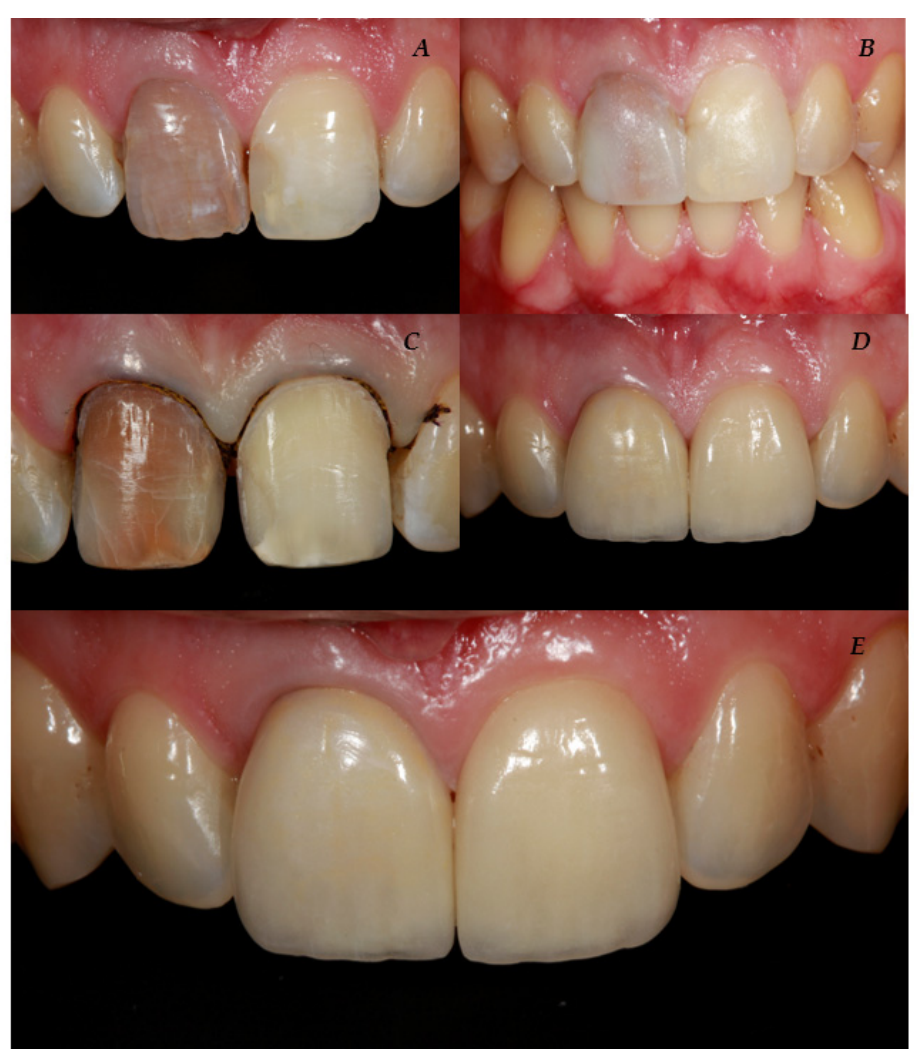
Figure 2. Description of the veneer preparation of two upper central incisors. ( A ) Preoperative situ- ation; ( B ) mock-up; ( C ) tooth preparation procedure; ( D ) immediately after cementation; and ( E ) 6 years